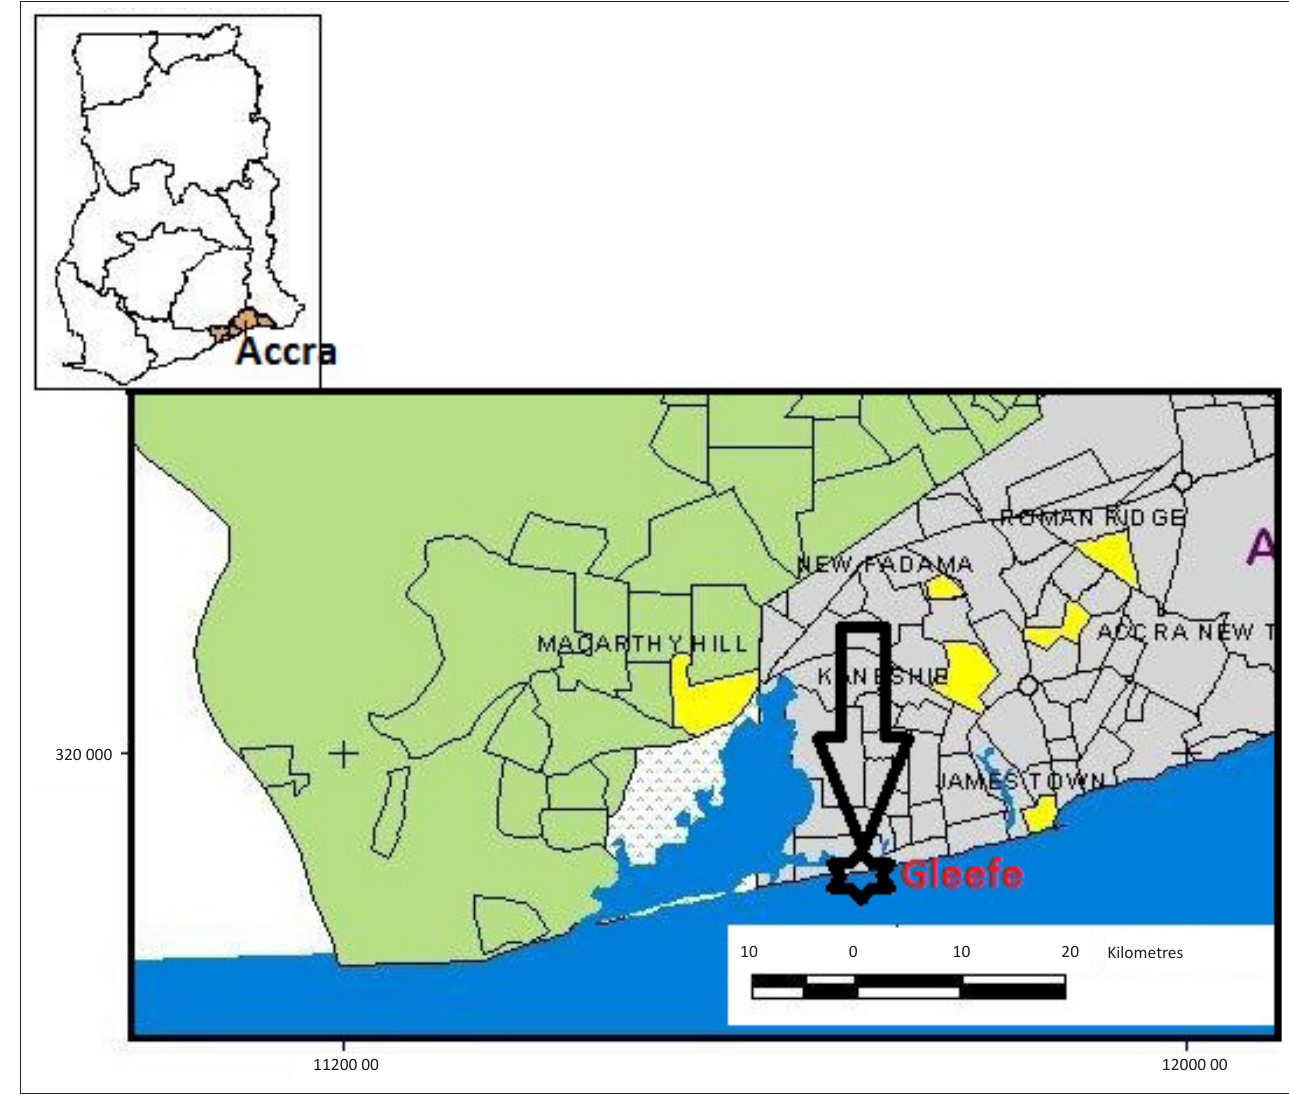
FIGURE 1: The study area showing its location in